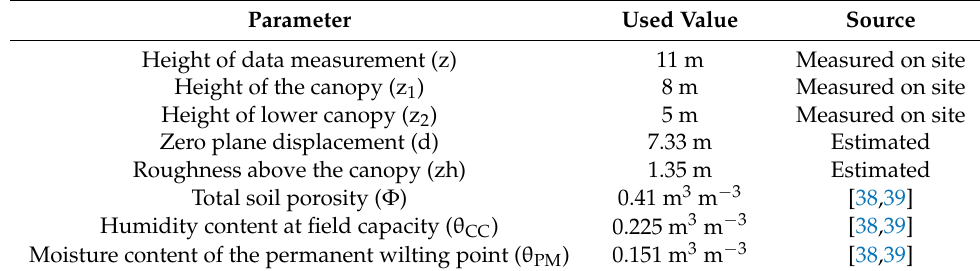
Table 1. Site-specific parameters used in the